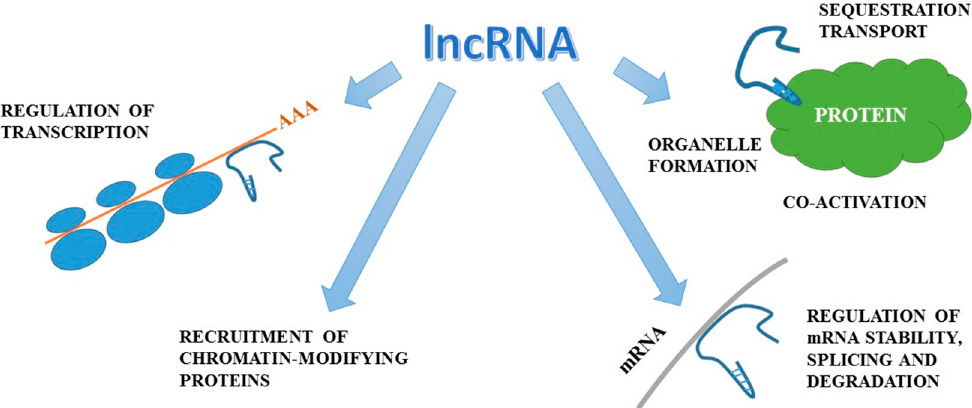
Figure 2. Mechanisms of action of lncRNA (figure was prepared and modified on the basis of [93]). The actions of lncRNA involve the interfering with protein-DNA binding, the regulation of mRNA stability and translation, the alteration of protein function, the organization of nuclear architecture and the modulation of mRNA levels and finally they are associated with the above mechanisms.